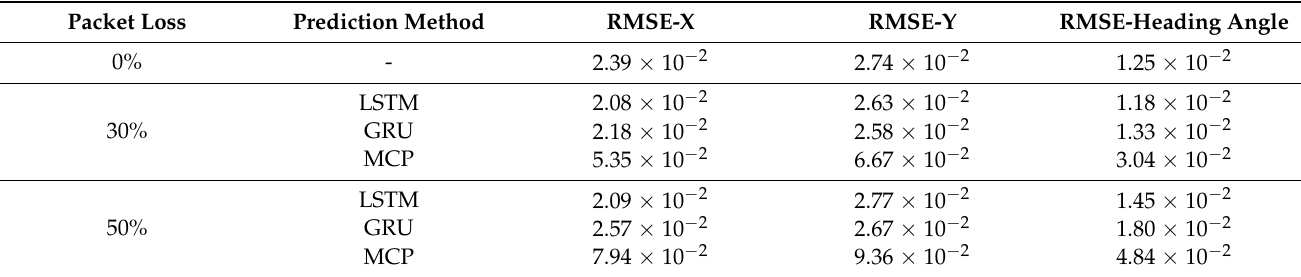
Table 4. RMSE of follower error for the eight-shaped